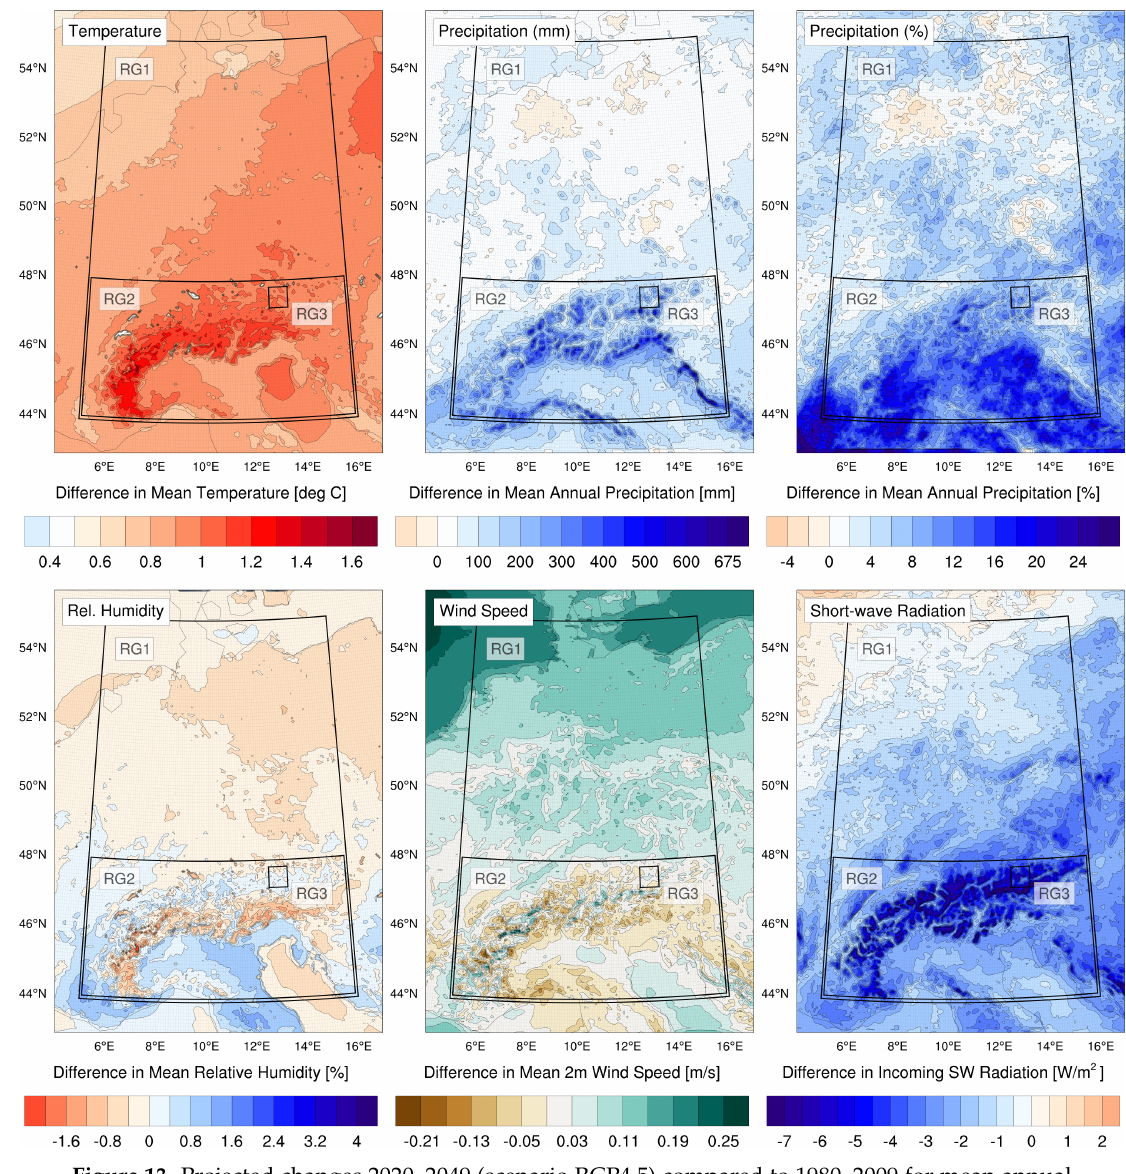
Figure 13. Projected changes 2020–2049 (scenario RCP4.5) compared to 1980–2009 for mean annual temperature (top left), precipitation (top center and right), humidity (bottom left), wind speed (bottom center), and short-wave radiation (bottom right) based on the 5 km simulation (domain D3). The black boxes mark the three investigated